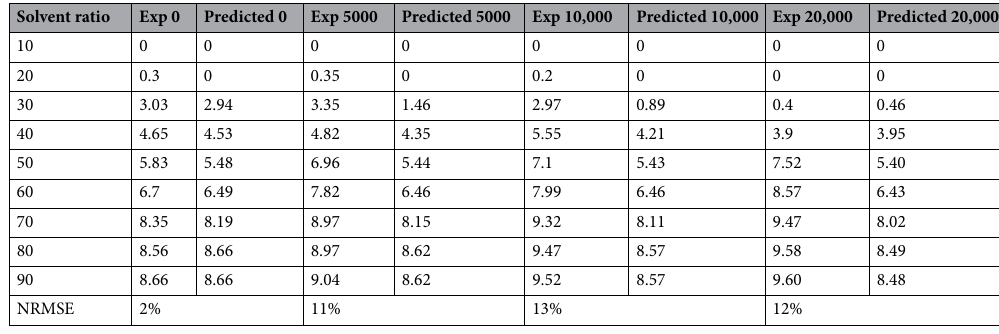
Table 5. Comparison of experimental and predicted asphaltene precipitation—Crude oil sample A (NRMSE = 9.8%).